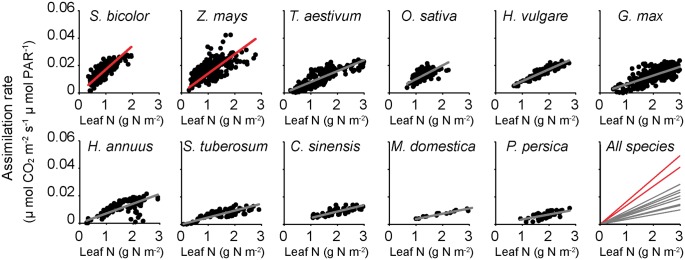
Scatter plots depicting the relationship between light saturated photosynthetic rate and leaf nitrogen content for the 11 species used in this analysis. A higher resolution plot with R2 values and slopes is provided as supplementary file S1, Supplementary Material online. Light saturated CO2 assimilation rate (µ mol CO2 m−2 s−1 µ mol PAR−1) and leaf nitrogen (g N m−2). Each fitted line is also provided on the plot labeled “All Species” to make it easier to compare the range of relationships that are observed between light saturated CO2 assimilation rate and leaf nitrogen. Fitted lines for C4 species are shown in red and fitted lines for C3 species shown in gray. The slope of each fitted line is the photosynthetic nitrogen use efficiency (PNUE) for each species. Sorghum bicolor (Muchow and Sinclair 1994; Anten et al. 1995; Tominaga et al. 2015), Zea mays (Muchow and Sinclair 1994; Lindquist and Mortensen 1999; Osaki et al. 2001; Paponov and Engels 2003; Drouet and Bonhomme 2004; Paponov et al. 2005; Vos et al. 2005), Triticum aestivum (Evans 1983; Fischer et al. 1998; Osaki et al. 2001; Müller et al. 2005), Oryza sativa (Anten et al. 1995; Osaki et al. 2001; Ohsumi et al. 2007; Hirasawa et al. 2010), Hordeum vulgare (Braune et al. 2009), Glycine max (Anten et al. 1995; Osaki et al. 2001; Maekawa and Kokubun 2005; Rotundo and Borras 2016), Helianthus annuus (Fredeen et al. 1991; Andrade et al. 1993; Gimenez et al. 1994; Trápani and Hall 1996; Bange et al. 1997; Rodríguez et al. 1998), Solanum tuberosum (Vos and van der Putten 1998, 2001), Citrus sinensis (Romero-Aranda and Syvertsen 1996), Malus domestica (Cheng and Fuchigami 2000), and Prunus persica (DeJong et al. 1989; Rosati et al. 1999; Malcolm et al. 2008).